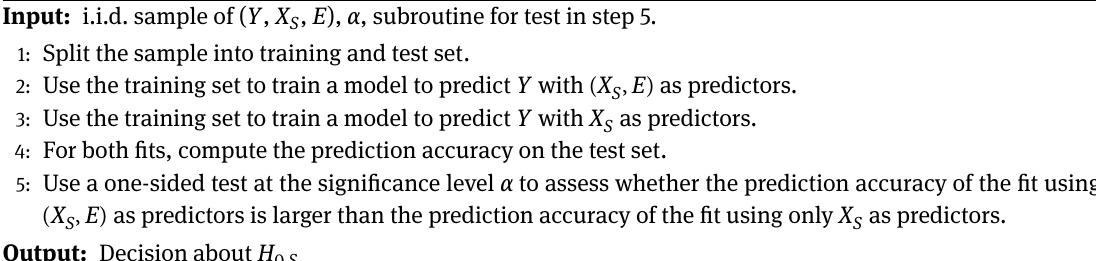
Algorithm 4 Invariant target prediction for nonlinear ICP.